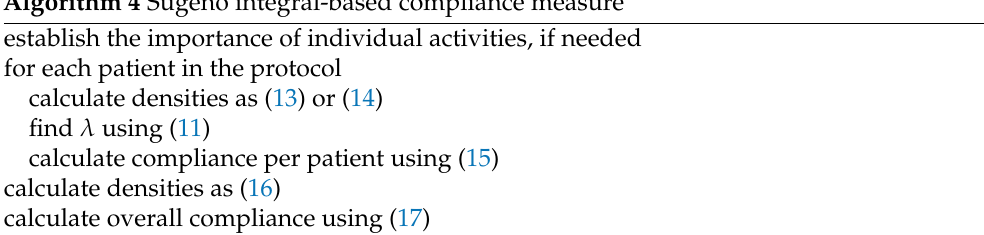
Algorithm 4 Sugeno integral-based compliance